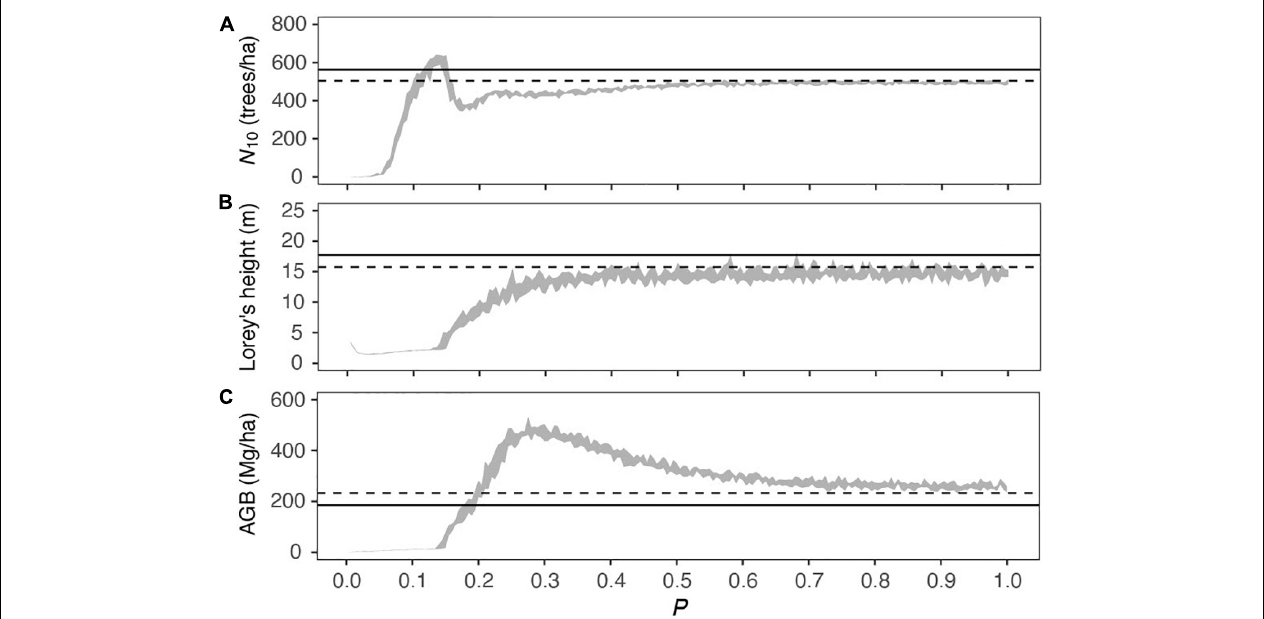
FIGURE 1 | Summary statistics of the simulated forests, in relation to the critical wind speed parameter P (smaller P means stronger effect): (A) N 10 , density of stems with DBH > 10 cm (trees ha − 1 ); (B) Lorey’s height, basal area-weighted mean tree height (m); (C) AGB, aboveground biomass (Mg ha − 1 ). Shaded areas represent the value range of five replicates for each simulation condition. Dashed lines represent simulation value with no wind disturbance, and Solid lines represent field observations.